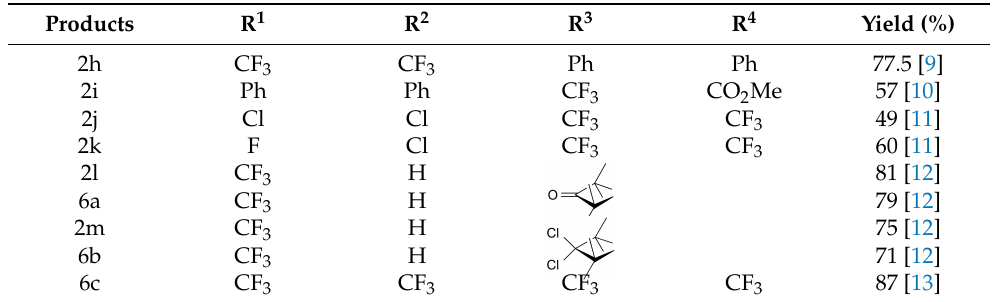
Table 1. Products of the [3+2]-cycloadditions of thiocarbonyl compounds 1 with diazoalkanes 5 (see Scheme